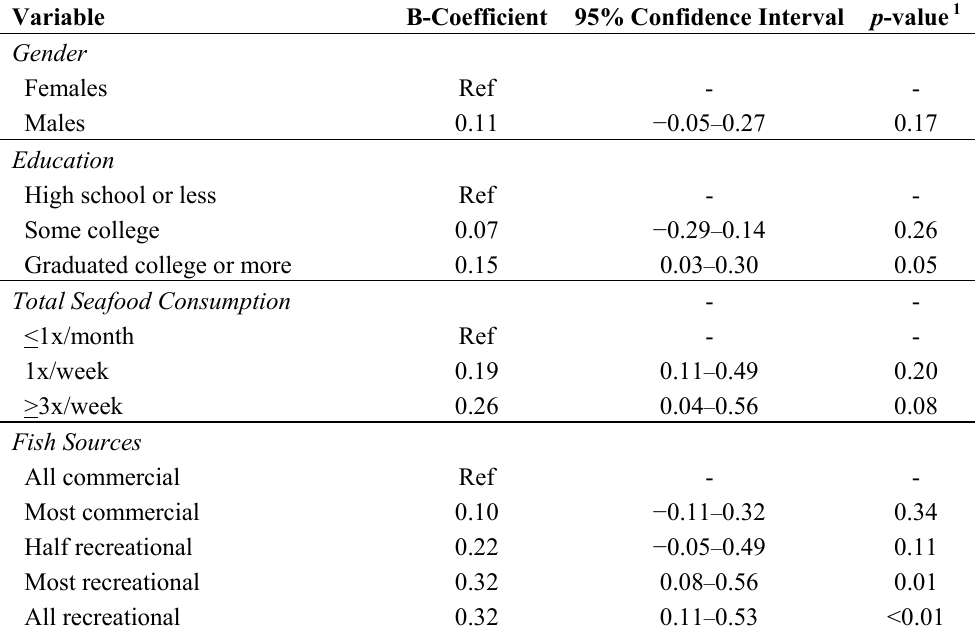
Table 3. Multivariable linear regression analysis of demographic variables, fish consumption frequency and sources of fish consumed on log total hair mercury